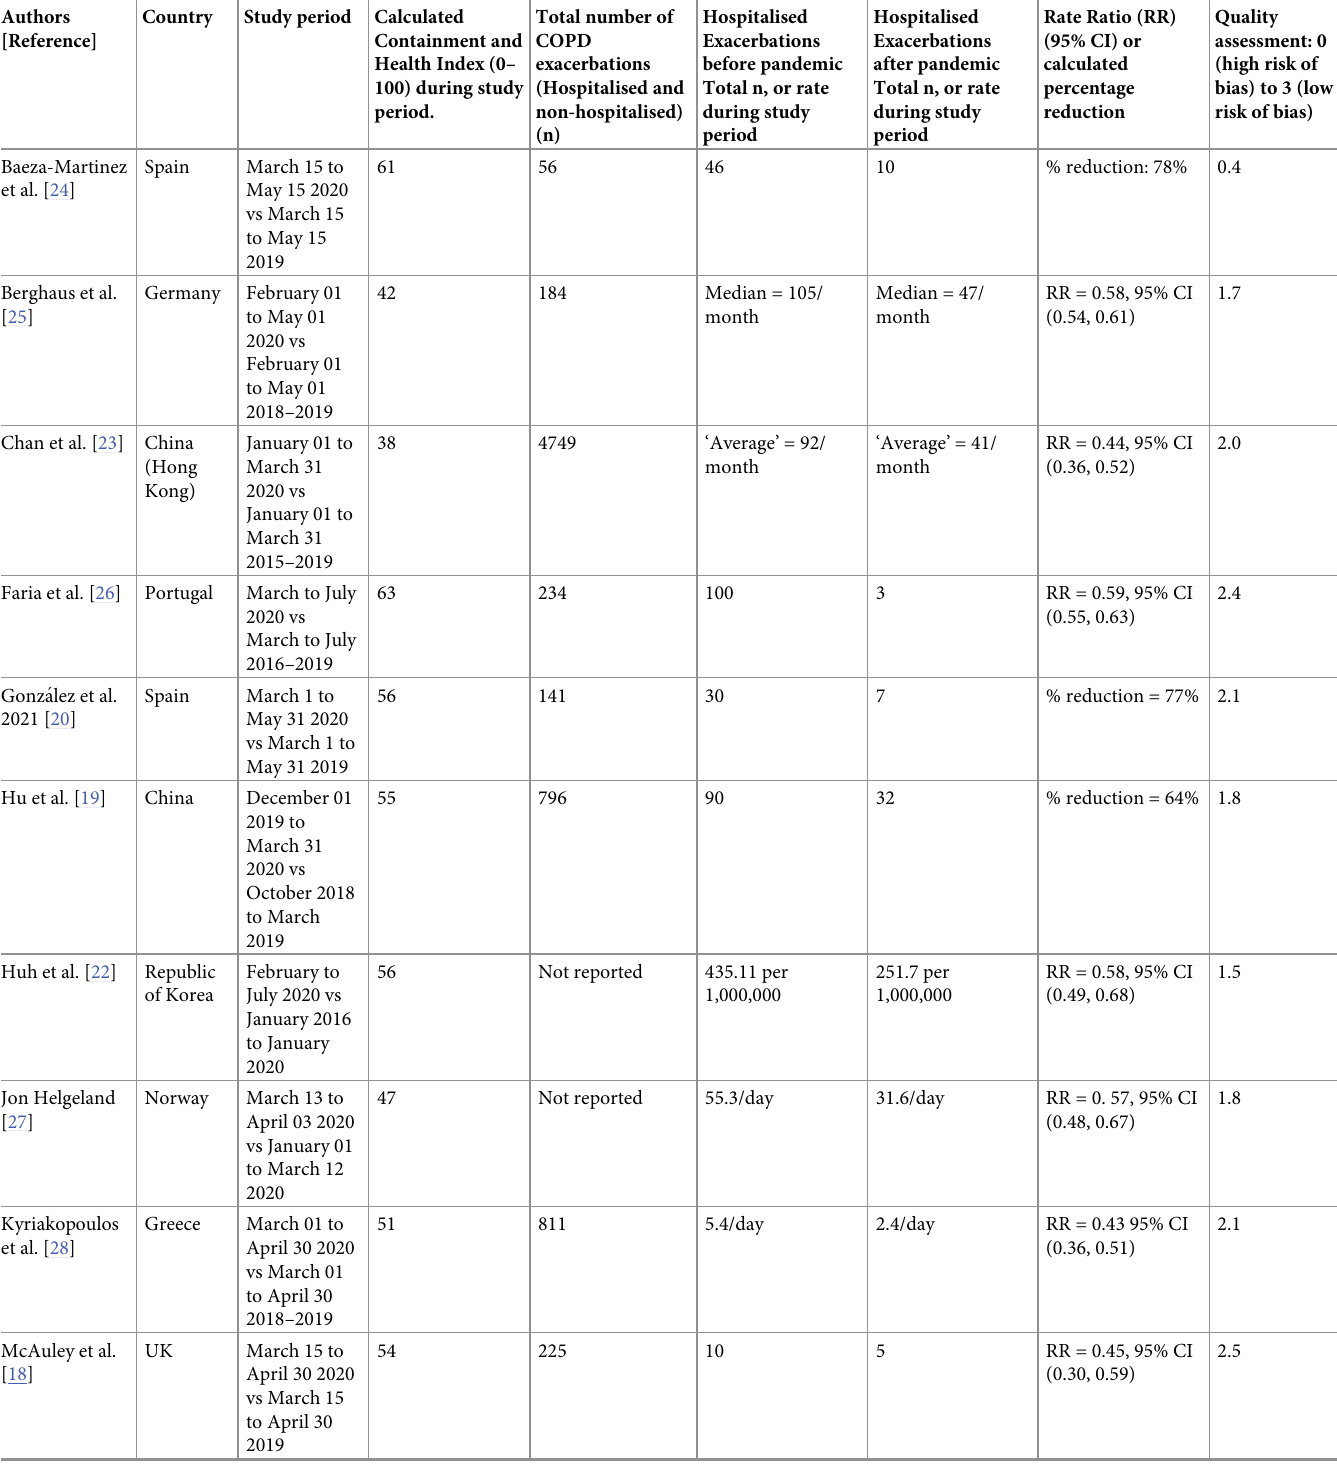
Table 1. Characteristics of included studies examining reduction in hospital admissions for exacerbations of